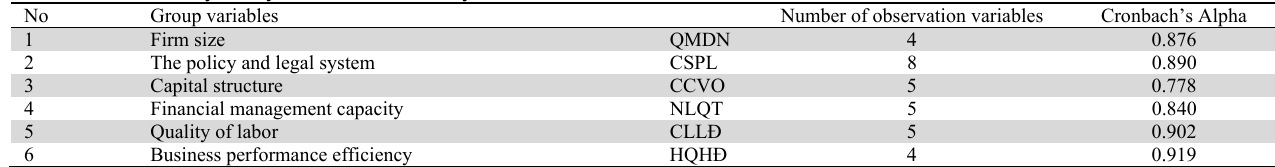
Rotation matrix of independent factors